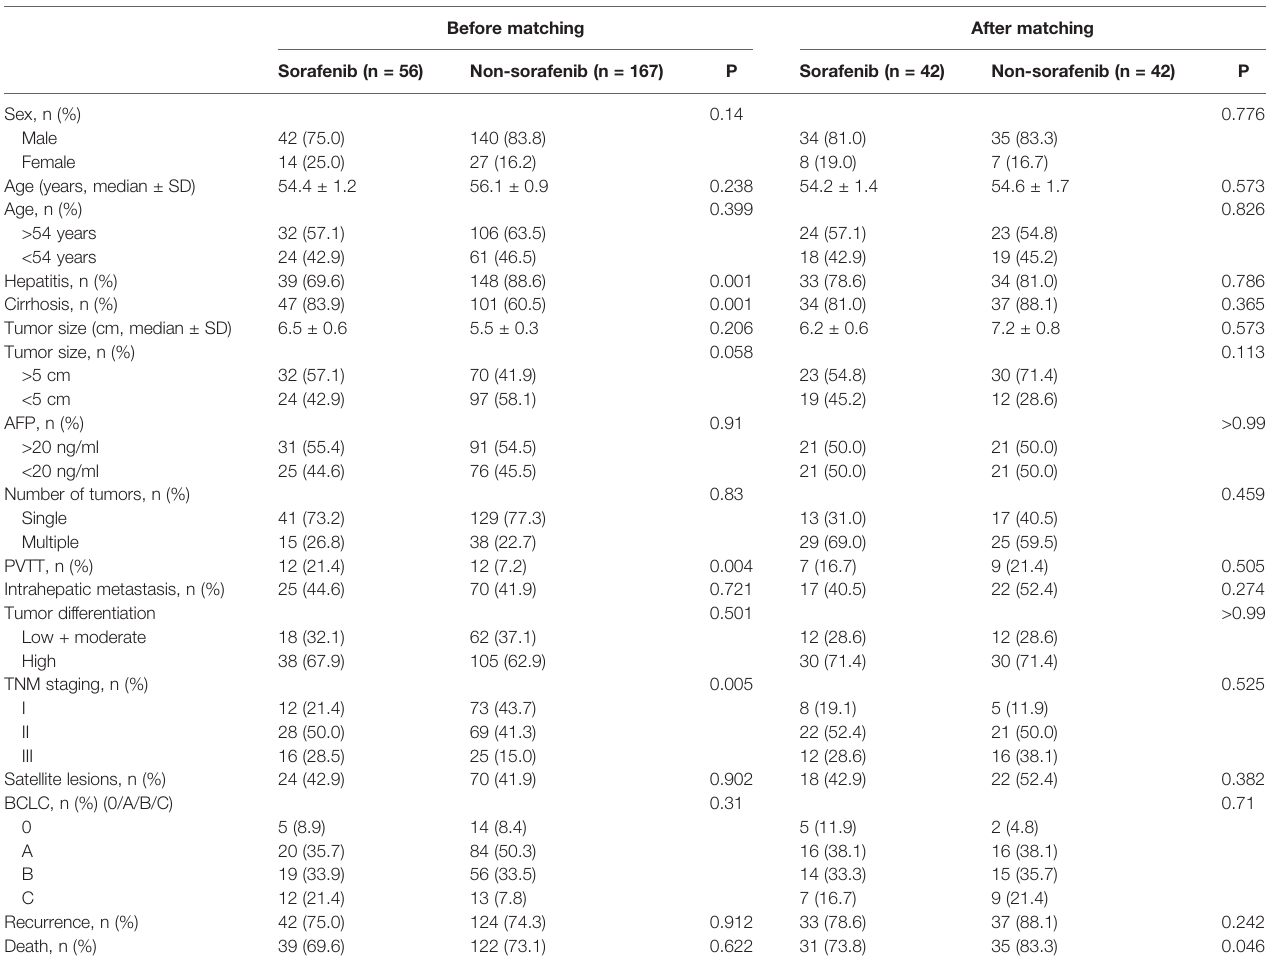
TABLE 1 | Clinical features before and after